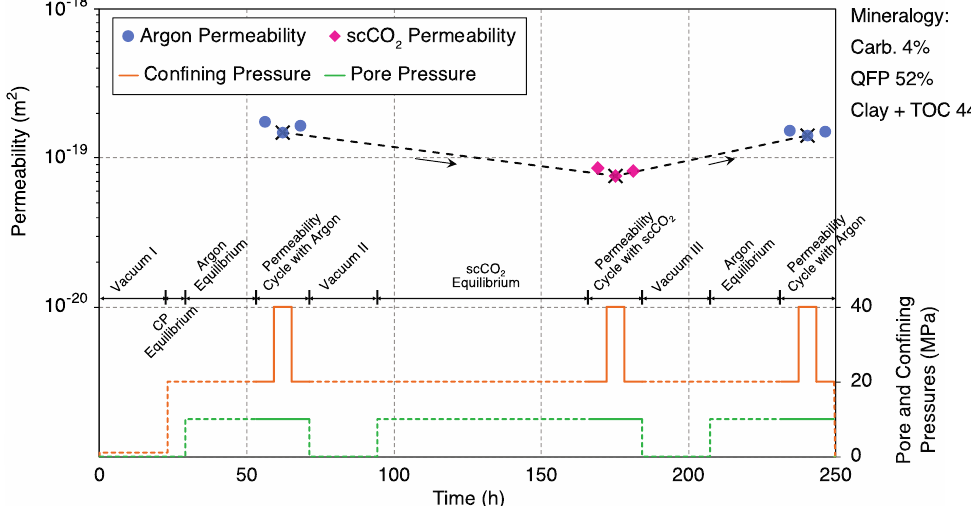
Figure 7. Permeability changes for sample 4-4H.